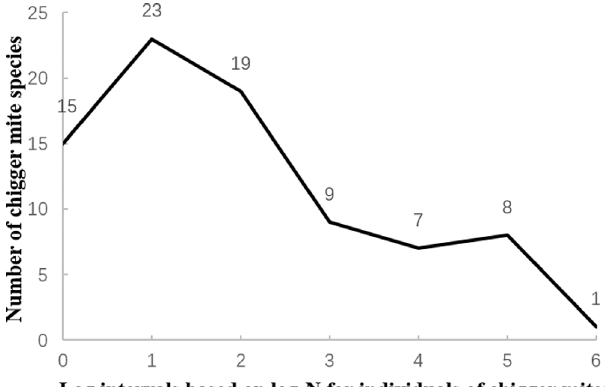
Figure 4. The species abundance distribution of the chigger community on Anourosorex squamipes between chigger individuals and their corresponding species in Southwest China (2001 –